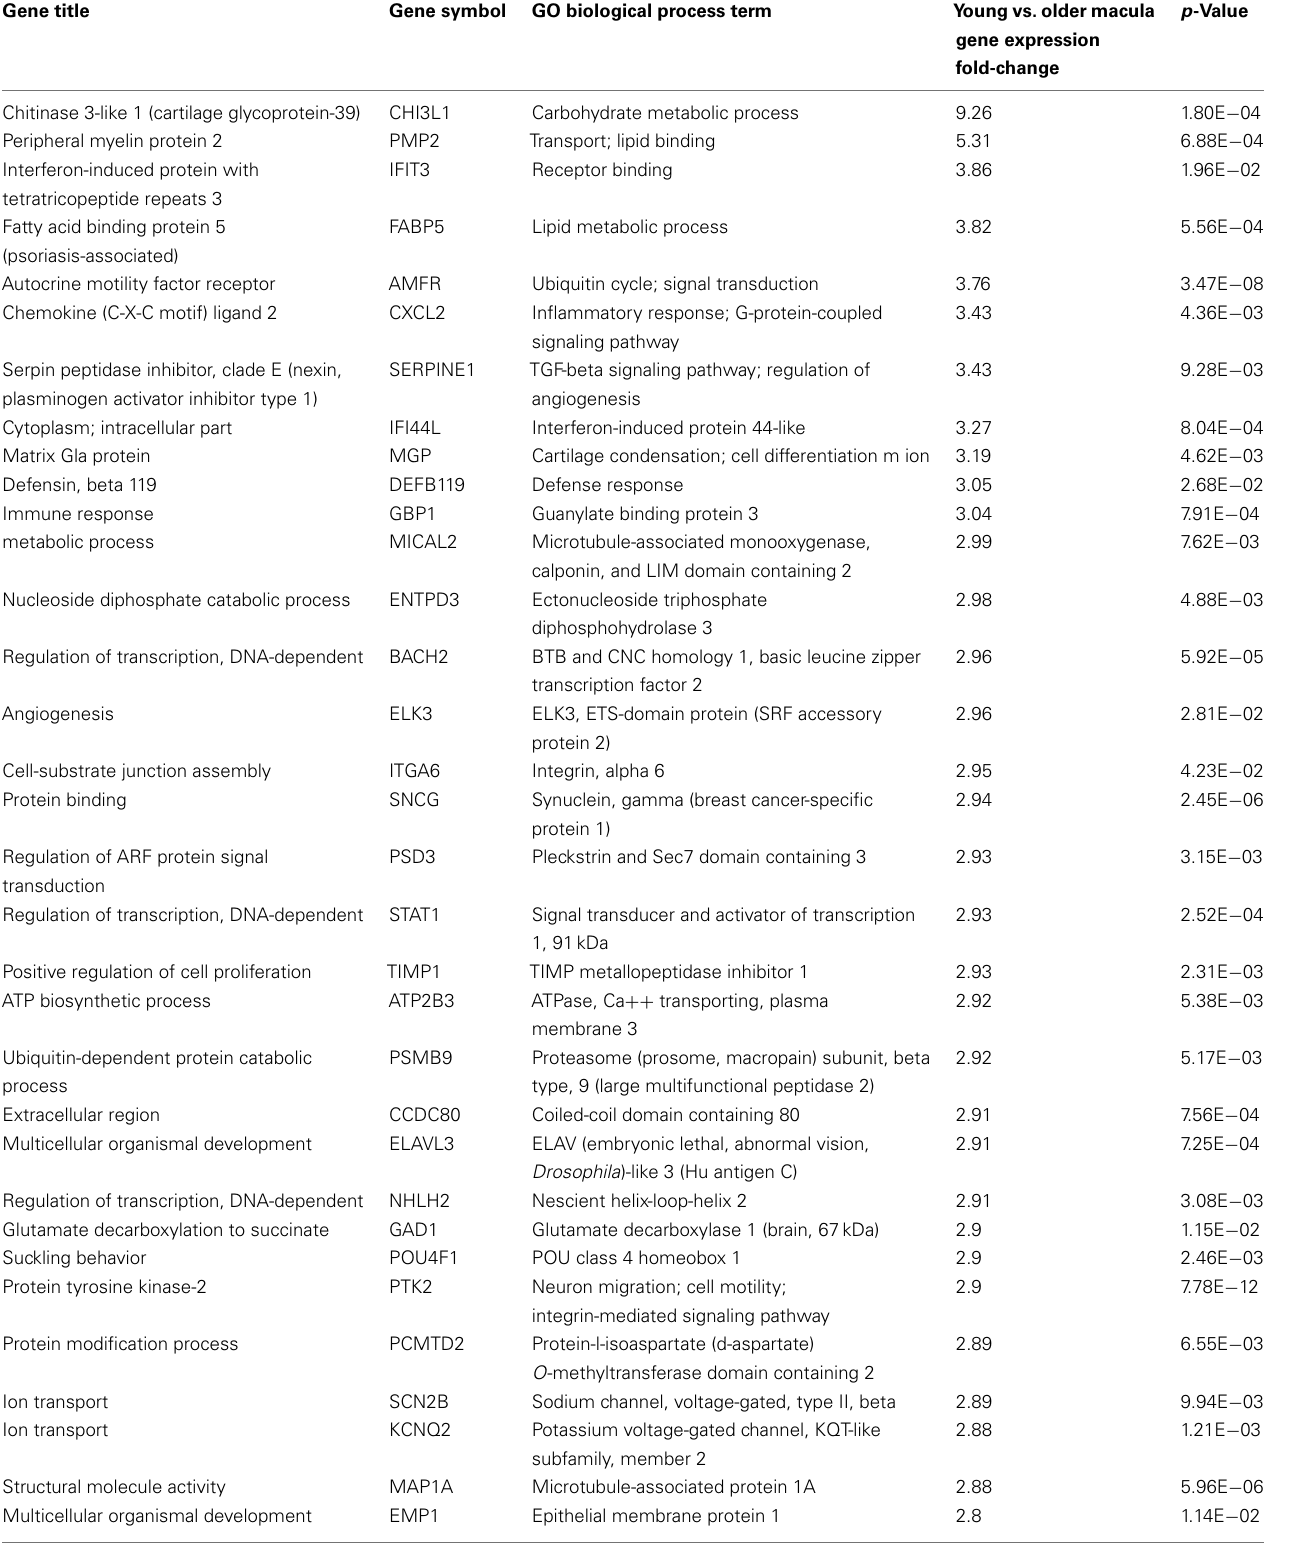
Table 5 | Genes highly expressed in young compared to old macular